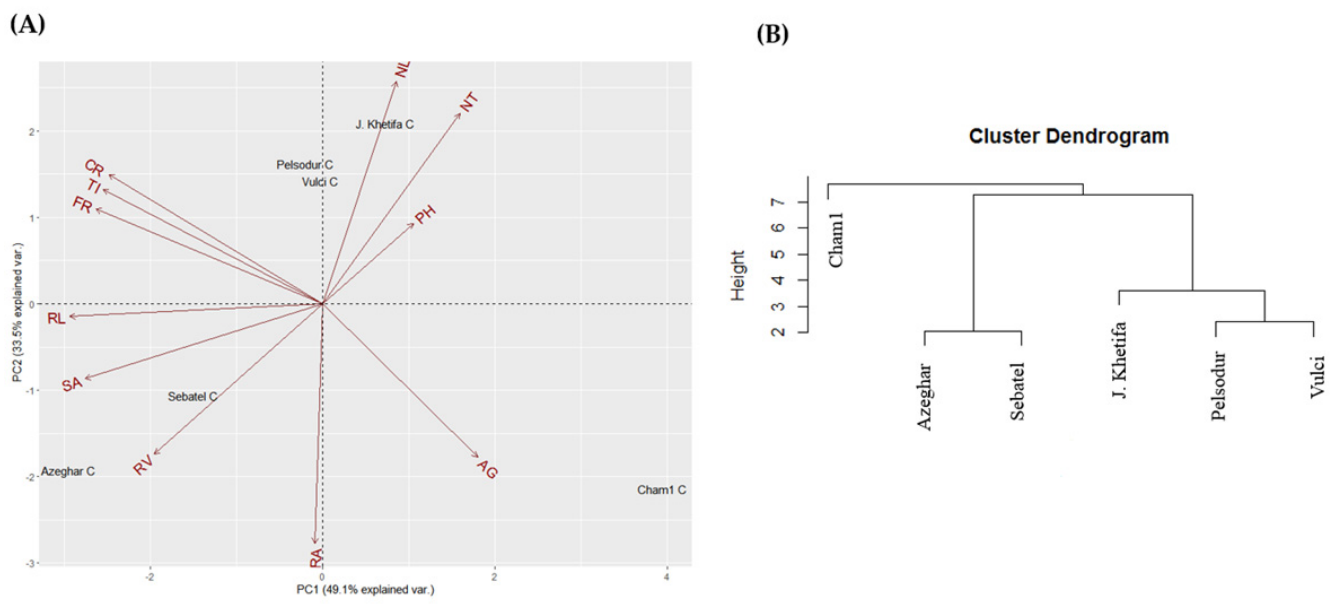
Figure 2. Biplot of the principal component analysis ( A ) and hierarchical analysis ( B ) of the shoot and root traits under control conditions. For abbreviations, please see the abbreviation list at the end of the paper.